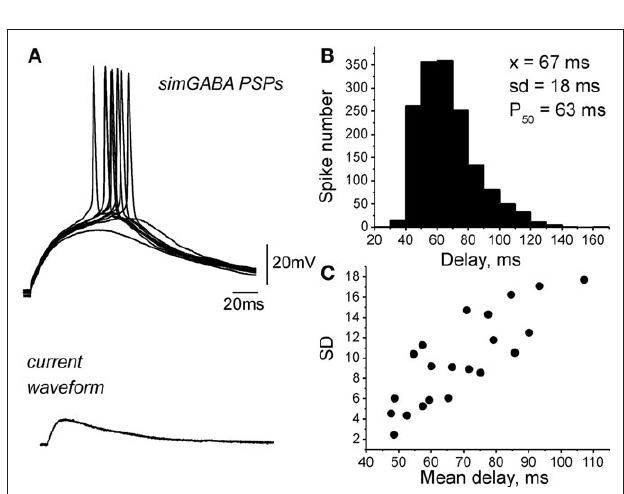
Figure 5 | gABA driving force, resting membrane potential, and the action potential threshold in neonatal CA3 pyramidal cells. (A, B) Measurements of the GABA driving force (A) and membrane potential (B) using cell-attached recordings of GABA and NMDA channels, respectively. Example traces of single